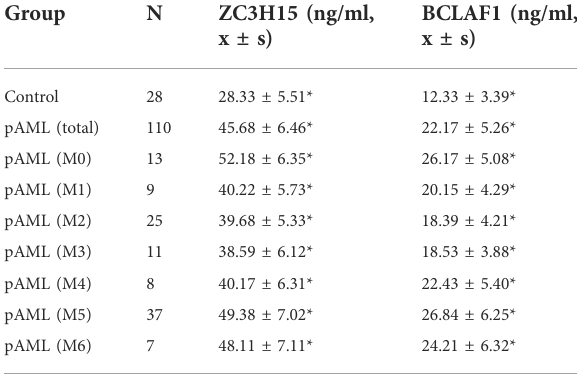
TABLE 1 Protein concentration of potential hub genes between control and different pAML